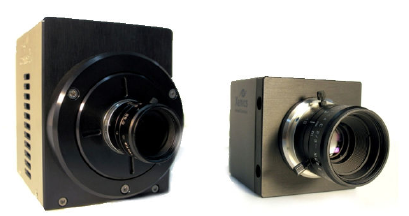
Figure 1. Cameras Xeva 1.7-320 and Xs 1.7-320